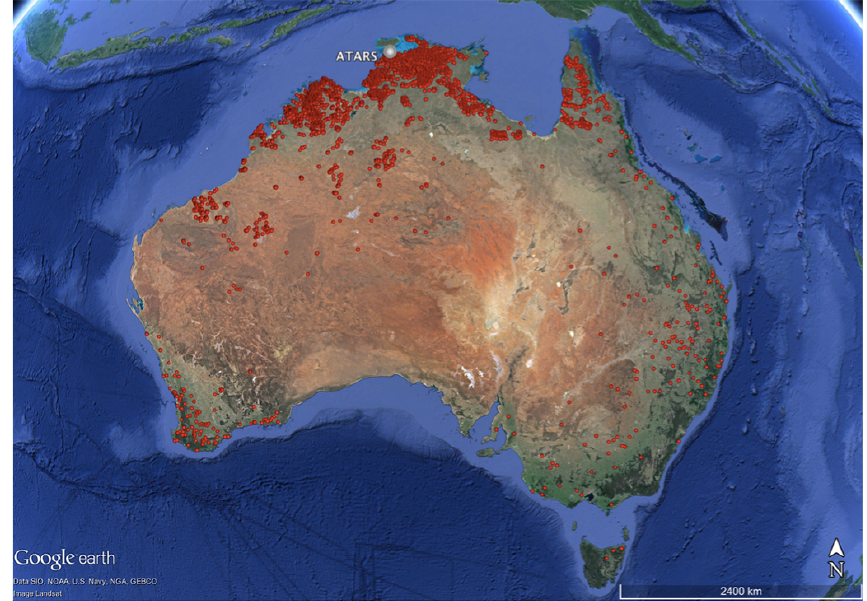
Figure 1. The total number of detected hotspots (confidence that hotspot is fire > 50%) between 30 May and 1 July 2014 in